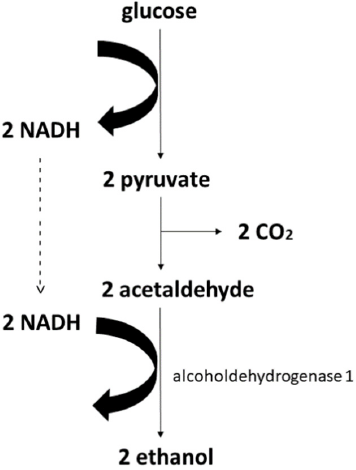
Figure 2. Ethanol formation from glucose in yeasts.